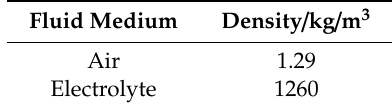
Table 2. The material properties of the fluid